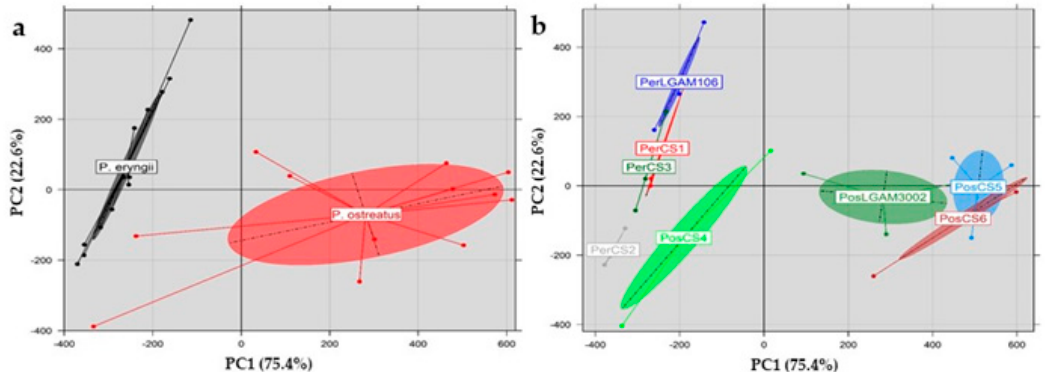
Figure 2. Score plot of principal component analysis and discrimination on the basis of the volatile compounds detected of Pleurotus mushrooms at ( a ) species and ( b ) strain level (Pos: P. ostreatus ; Per: P. eryngii ).